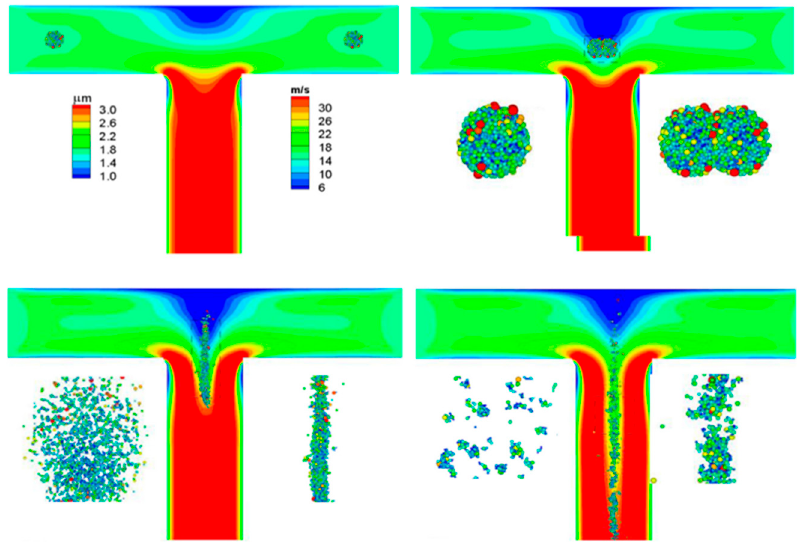
Figure 4. Breakage pattern of agglomerate due to collision simulated by Tong et al. [37] at the progression time. Reproduced with permission from [37], Elsevier, 2016.